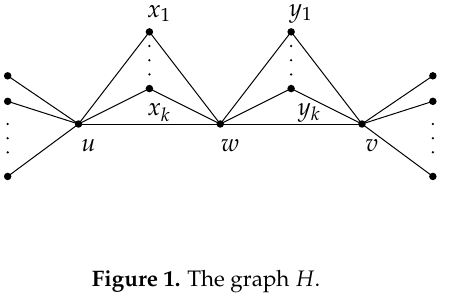
Figure 1. The graph H